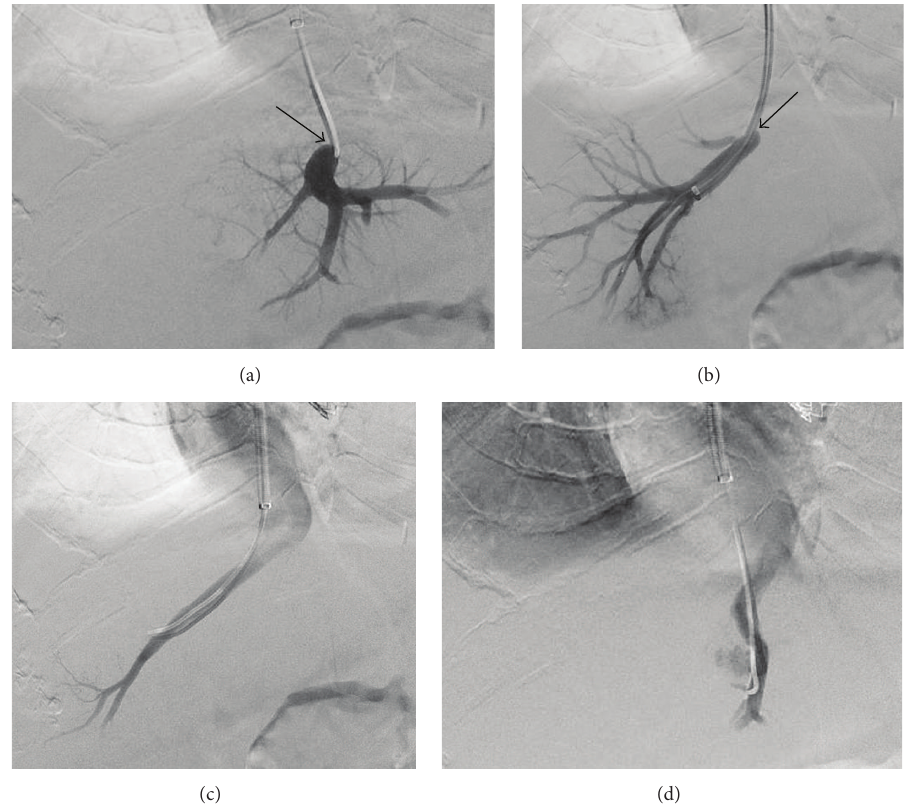
Figure 1: Middle (a) and right (b) hepatic venography showed tight segment stenoses (arrows). Angioplasty was first performed on the right hepatic vein, and repeat venography showed rapid contrast flow into the right atrium (c). The procedure was repeated in the middle hepatic vein (d).